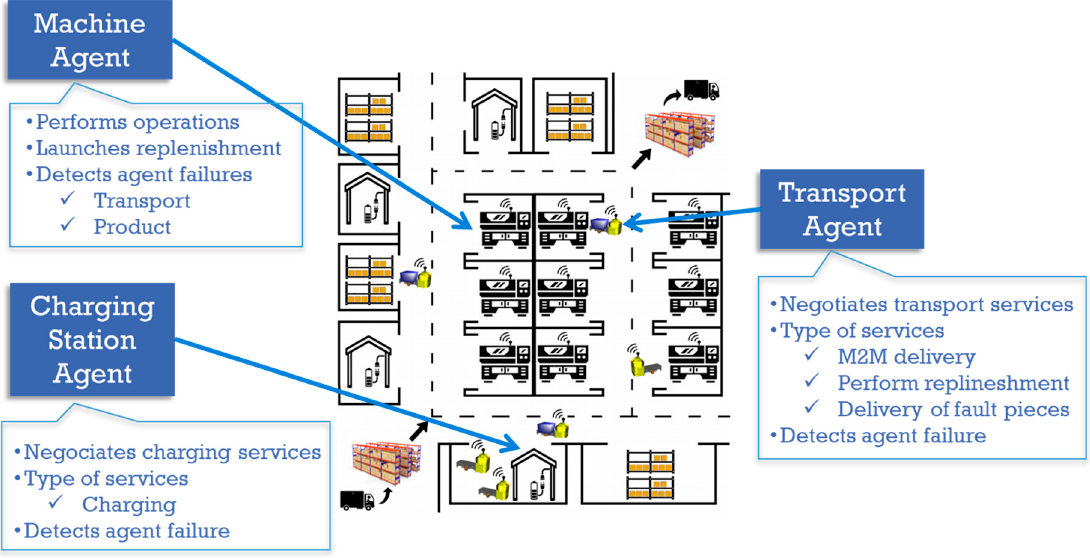
Figure 8. Factory layout for the validation of the uses cases.